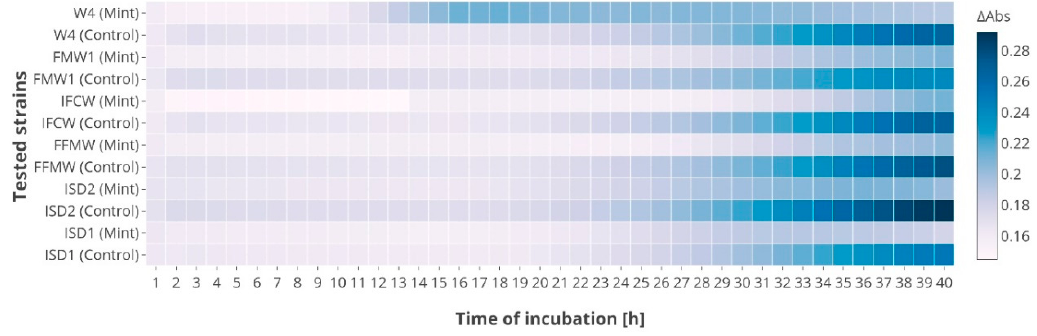
Figure 1. The growth of As. bogorensis (ISD1, ISD2, FFMW) and As. lannensis (IFCW, FMW1, W4) in the control culture medium and the medium with mint extract.